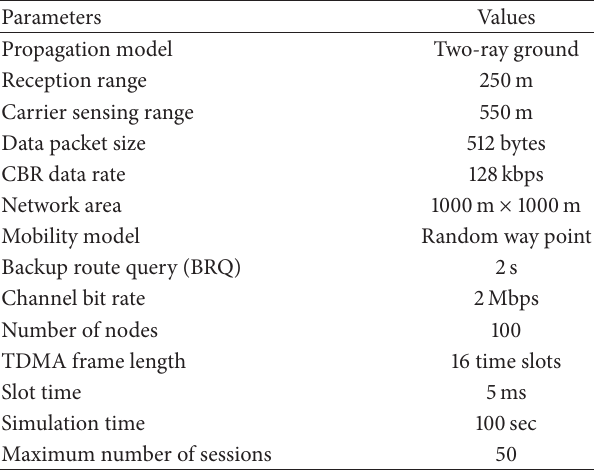
Table 1: Parameter